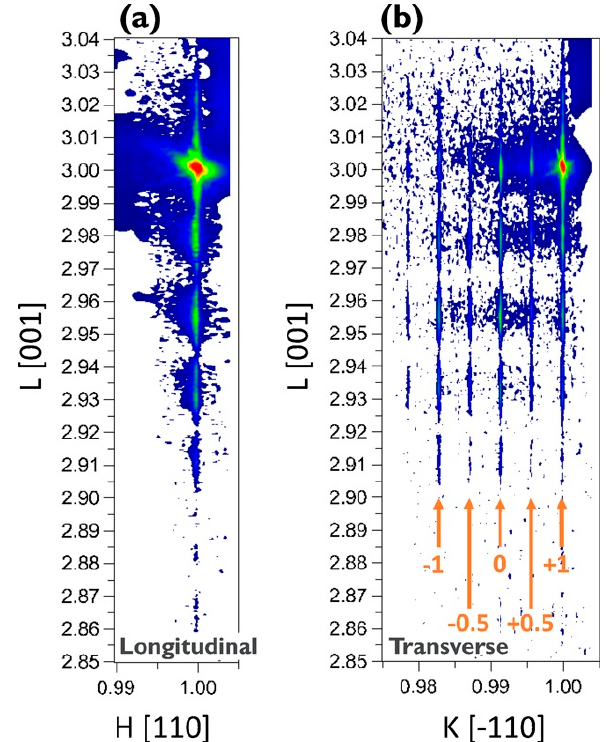
Figure 69. HRRLMs of (113) reflection obtained from fins with width of 20 nm in ( a ) longitudinal and ( b ) transverse direction [441].